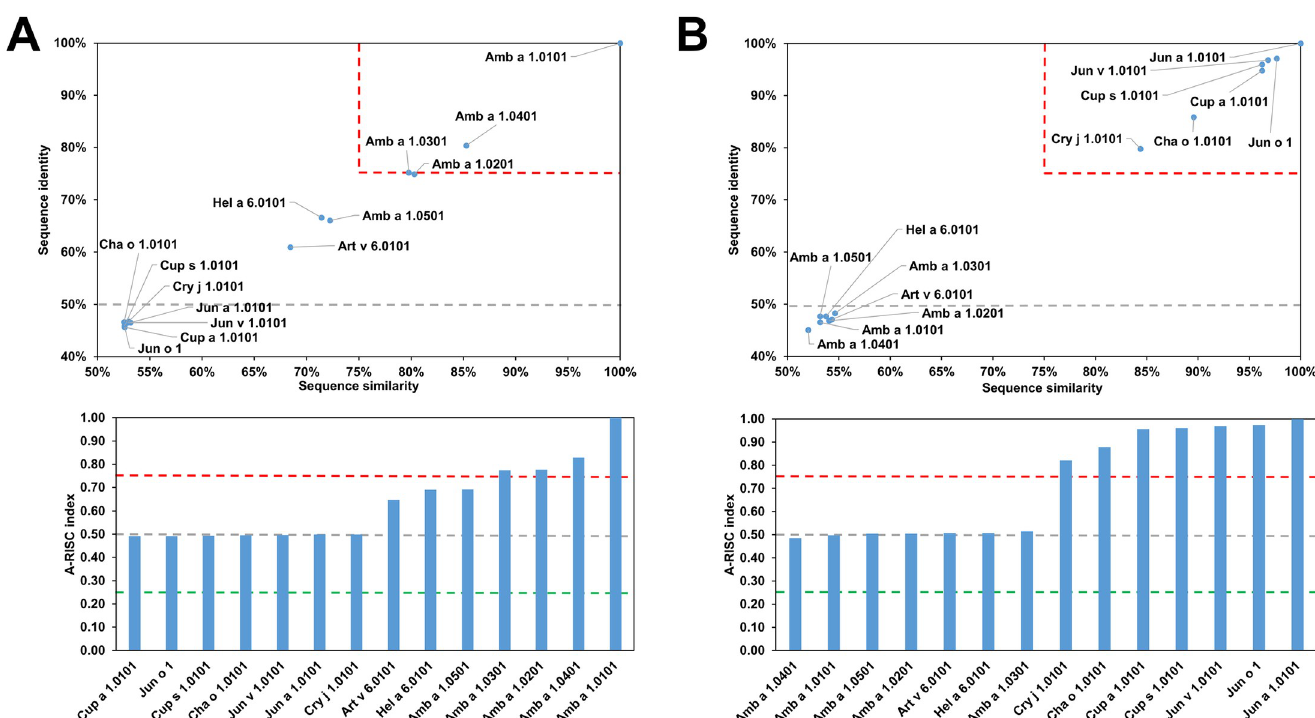
Fig 10. Plots showing relative homology and A-RISC indexes of allergens from pectate lyase family. Comparison of family members to Amb a 1.0101 (A) and Jun a 1.0101 (B). Red, gray, and dark green dashed lines indicate respectively 75%, 50% and 25% sequence identity and similarity, or 0.75, 0.50 and 0.25 A-RISC values.